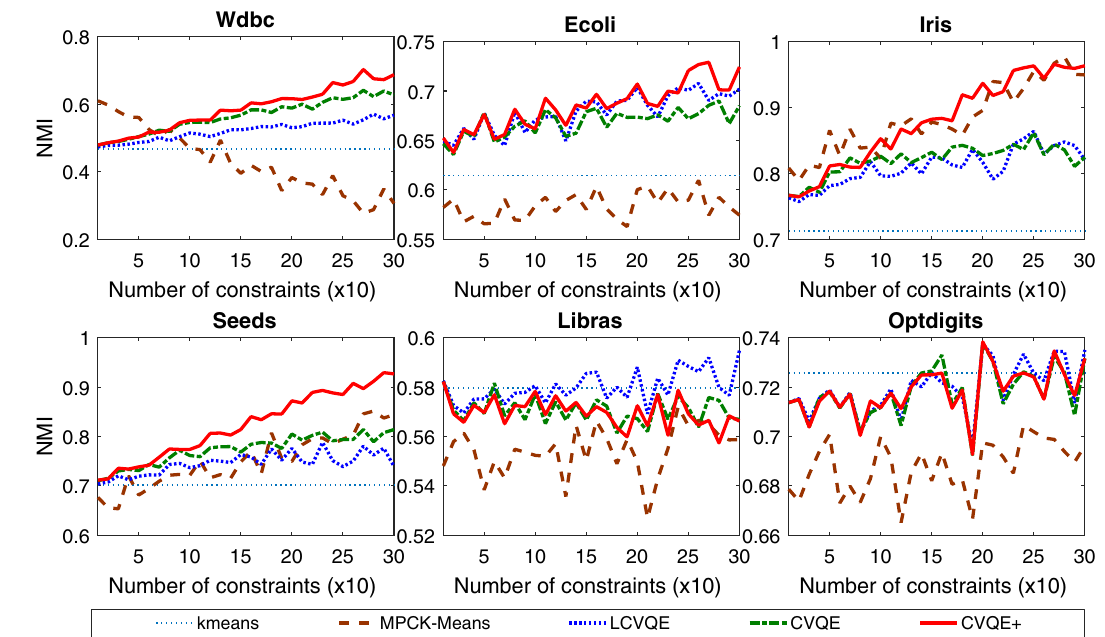
Fig. 5 Performance of CVQE+ compared to